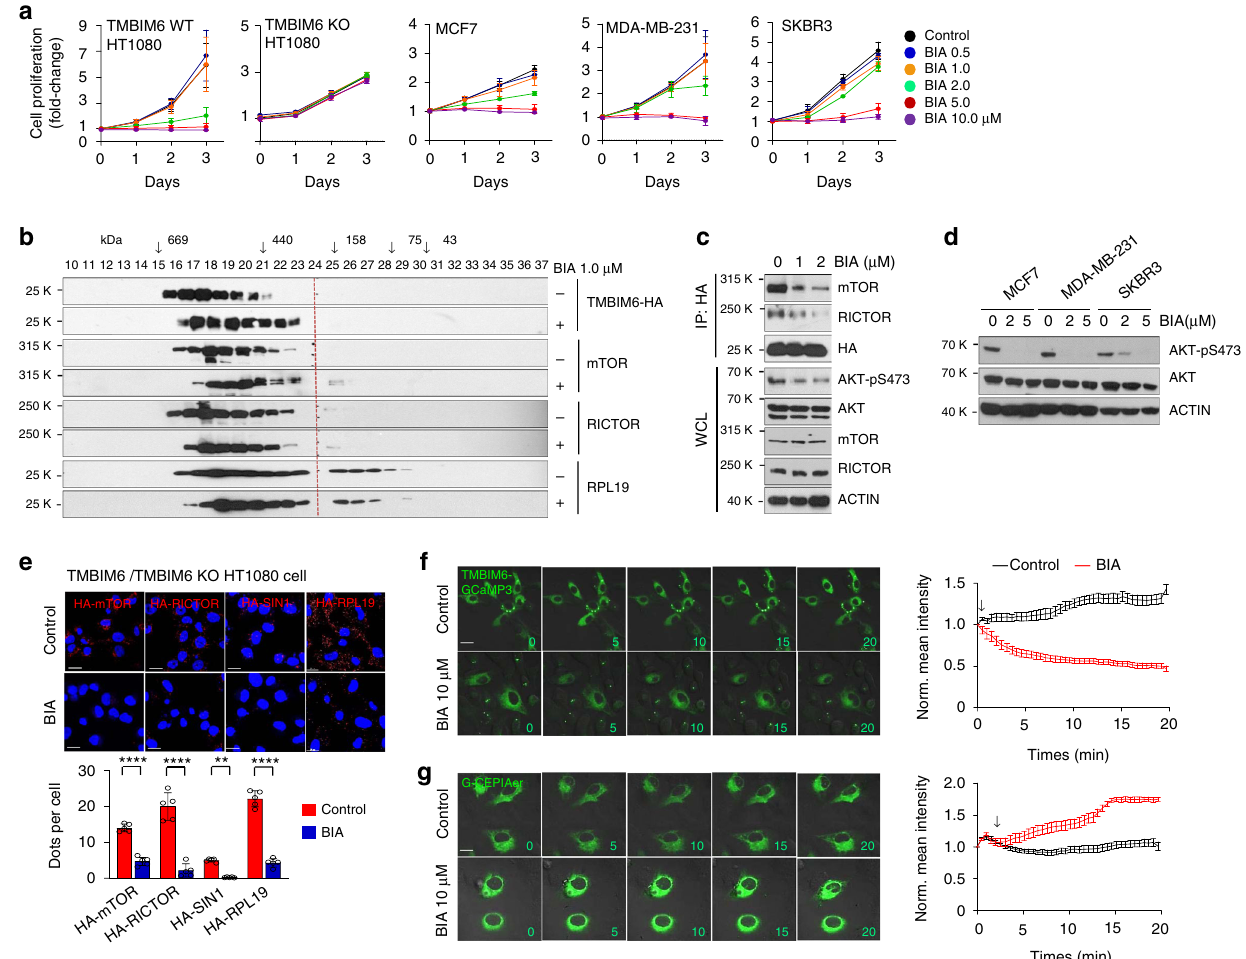
Fig. 7 BIA, a TMBIM6 antagonist, suppresses tumor growth. a Proliferation of TMBIM6 WT HT1080, TMBIM6 KO HT1080, MCF7, MDA-MB-231, and SKBR3 cells treated with BIA ( n = 3 independent experiments). Data are presented as means ± SD. b Gel fi ltration assay of HT1080 cells treated with 1.0 μ M BIA. The red line represents the size marker. c Immunoblot analysis of anti-HA immunoprecipitate (IP) and whole cell lysate (WCL) of HT1080 cells transiently overexpressing TMBIM6-HA and treated with BIA. d Immunoblotting of p-AKT, AKT, and actin in the indicated cell lines following treatment with BIA. e PLA between TMBIM6-HA and mTORC2 components or between TMBIM6-HA and RPL19 (red dots) in BIA-treated or non-treated TMBIM6 stably overexpressing HT1080 cells. Bottom, quanti fi cation of red dots ( n = 5 independent experiments). Scale bar, 20 μ m. Data are presented as means ± SD. ** p < 0.01, **** p < 0.0001, two-way ANOVA followed by Bonferroni ’ s post hoc test. f , g Real-time lapse images of HT1080 cells stably expressing TMBIM6-GCaMP3 and G-CEPIAer treated with BIA. Right, mean green intensity of every cells normalized to untreated cells ( n = 5 independent experiments, total of 20 cells for TMBIM6-GCaMP3; total of 16 cells for G-CEPIAer). Scale bar, 15 μ m. Data are presented as means ±